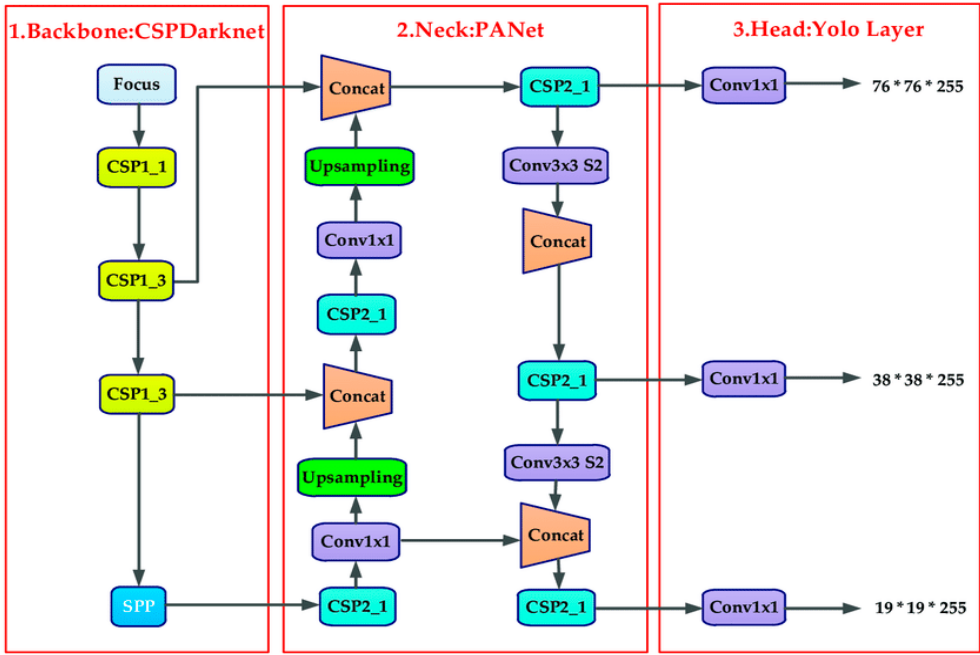
Figure 3. YOLO v5 architecture [39] .